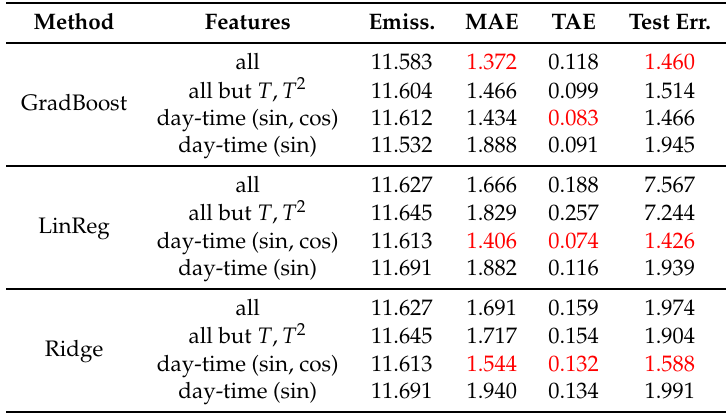
Table 2. Averaged emission (Emiss.), mean absolute extrapolation error (MAE), total absolute error (TAE), and mean absolute test error (test err.) averaged over all scenarios. Emission, MAE, TAE and test error are provided in g h − 1 LU − 1 . Note: The averaged experimental emission was 11.596 g h − 1 LU − 1 . The smallest errors are highlighted in